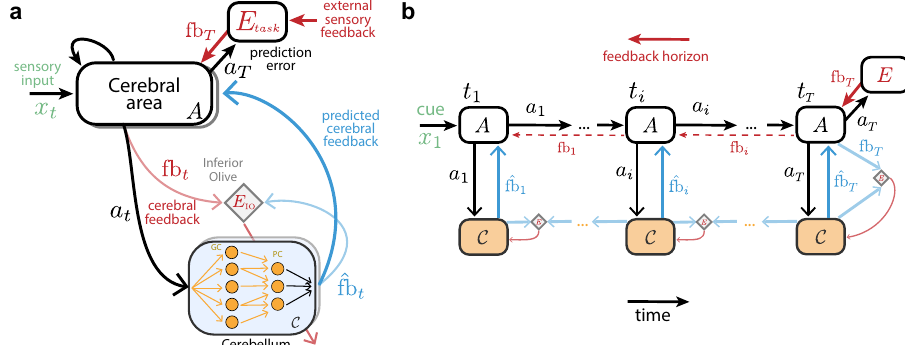
Fig. 1 | Cerebro-cerebellar networks as feedback prediction machines. a Arecurrentcerebralcorticalnetwork A learnsthroughexternalsensoryfeedback givenbyatask-speci fi cpredictionerrormodule E Task computedattheendofatask fb T (top red arrow). The cerebellum aims to continuously predict the feedback expected by the cerebral network ^ fb t (blue) given current cerebral activity a t (black). The cerebellar network (i.e. granule cells; GC and Purkinje cells; PC) learns through prediction errors (bottom red arrow) computed at the inferior olive (diamond) by comparing predicted cerebral feedback ^ fb t with actual cerebral feedback fb t (light blue). Shaded boxes represent multiple cerebral areas and cer- ebellar modules that may be interacting in parallel (see Fig. S1 for the same fra- mework applied to decoupling across multiple brain areas). b Example of cerebro-